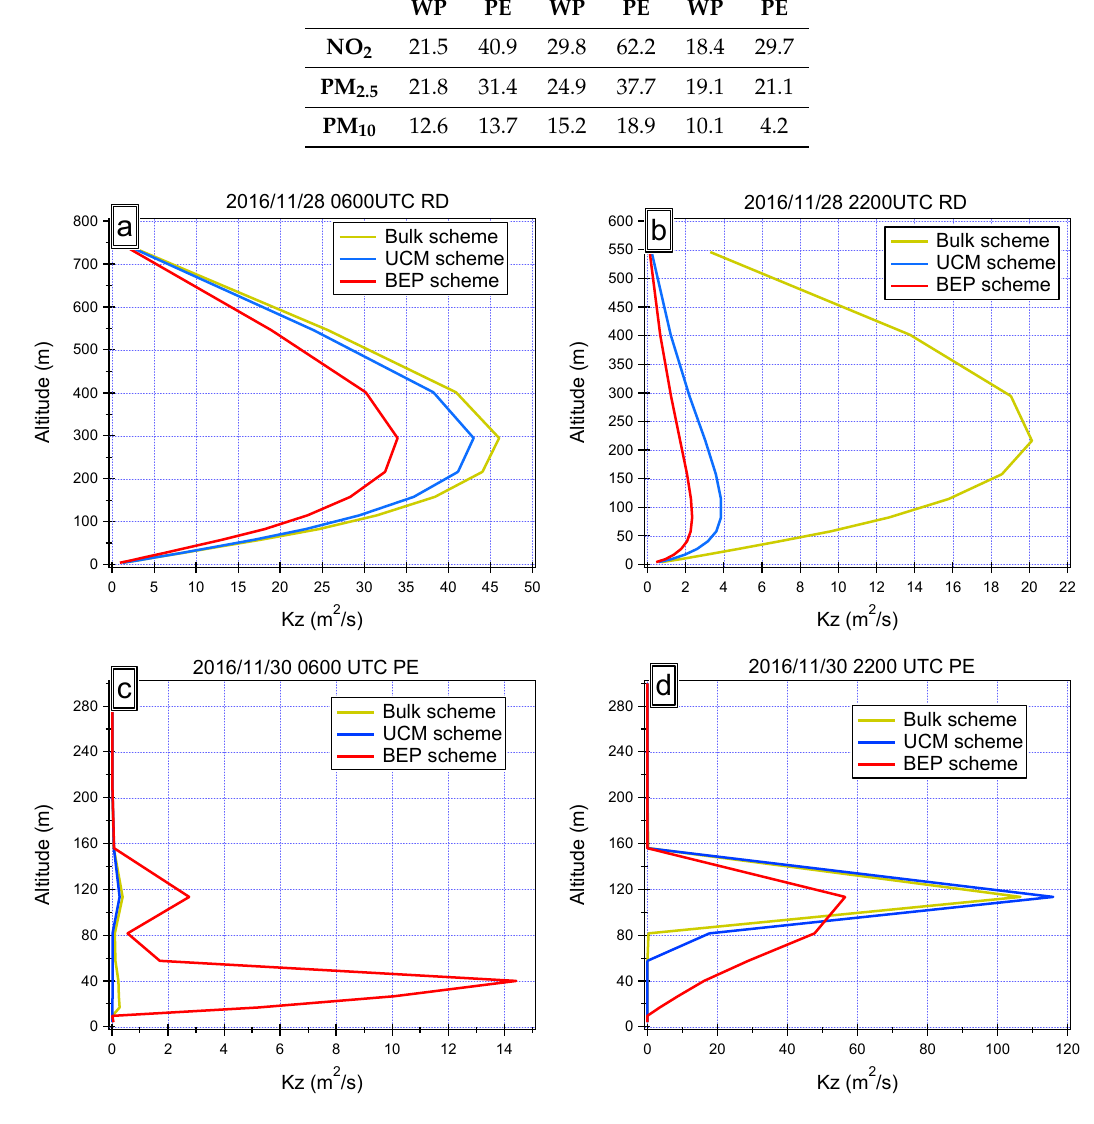
Figure 12. Vertical profiles of the CHIMERE Kz extracted at the FR04143 station. The profile is extracted at 06:00 and 22:00 UTC for both Regular Days (RD) and the Particulate Episode (PE).